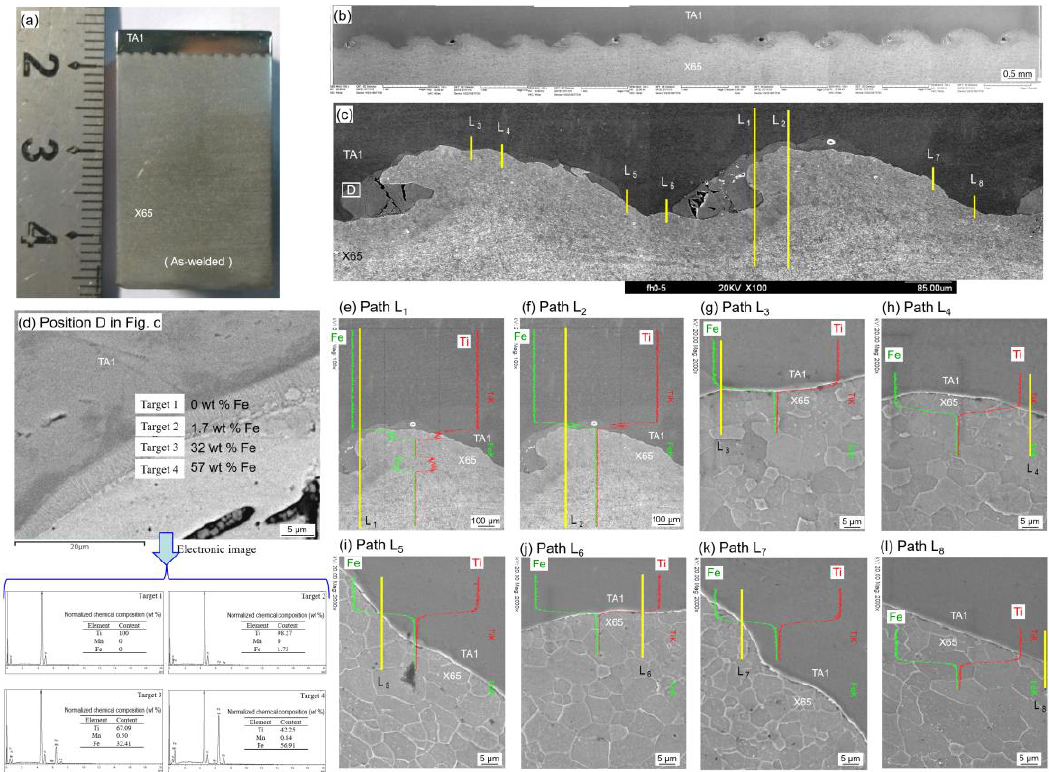
Figure 4. Test results for as-welded TA1/X65 bimetallic sheet by Xie et al. [21] ( a ) macrograph of cross-section; ( b ) wavy interface; ( c ) typical morphology of the wavy interface; ( d ) high-resolution image (HRI) and micro-zone analysis results (MAR) of position D in panel c; ( e – l ) results of line scanning.